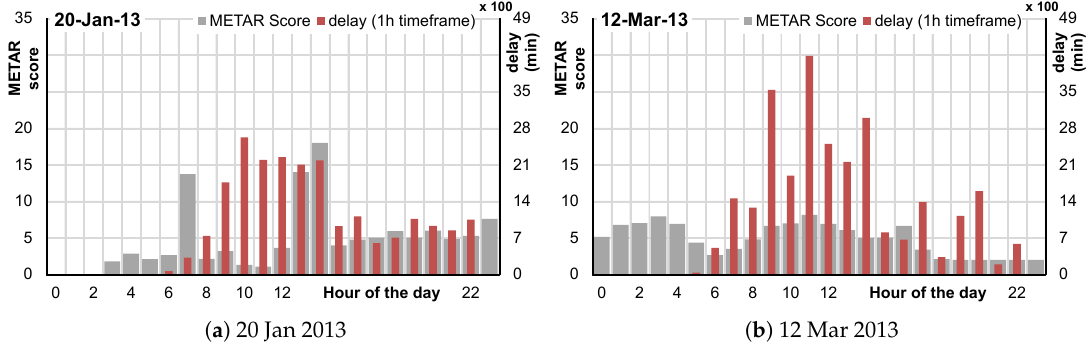
Figure 12. Weather/delay progress considering freezing